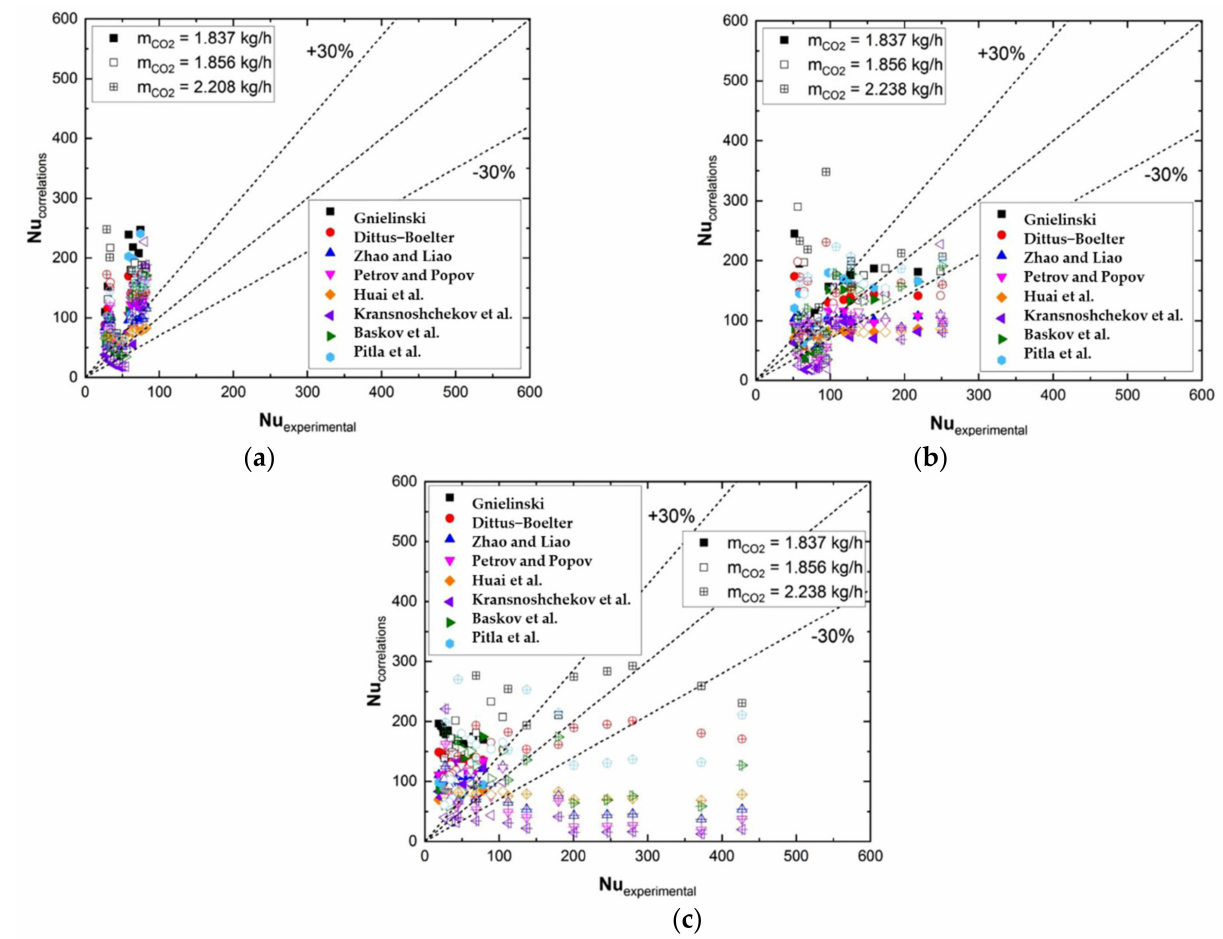
Figure 16. Comparison of experimental data and empirical correlations on Nusselt number at P = 7.63 MPa [38]: ( a ) horizontal, ( b ) vertical downward, ( c ) vertical